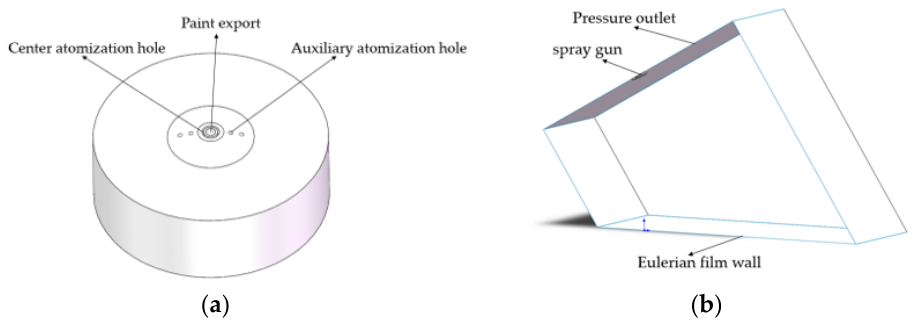
Figure 1. Spray gun model and computational domain model.